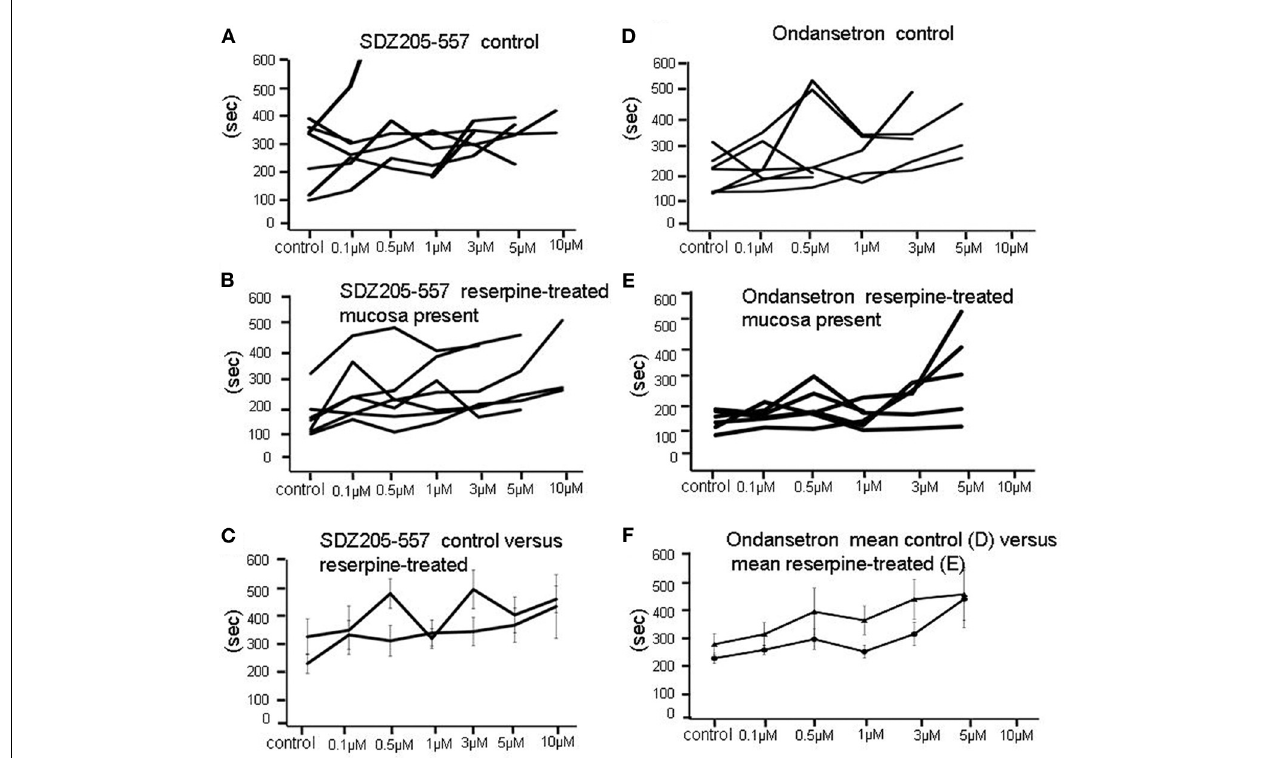
FIGURE 5 | Effects of application of SDZ-205-557 or ondansetron on the intervals between repetitive peristaltic contractions. (A) Show a graphical representation of the responses of individual preparations of colon to SDZ-205-557. No clear changes are seen. (B) similar lack of effect of SDZ-205–557 on reserpine treated animals, in which the mucosa was present. (C) Shows the mean changes in interval between peristaltic contractions in control (A) and reserpine-treated (B)